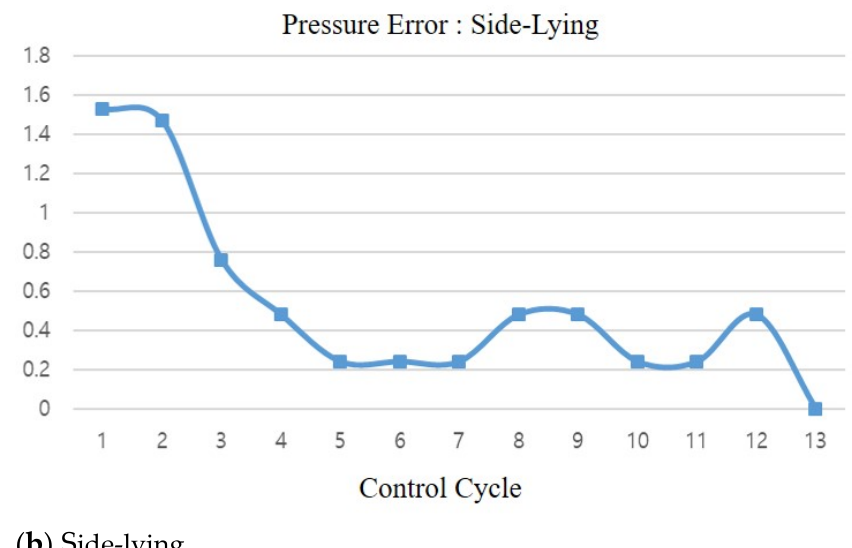
Figure 14. Fuzzy pressure control performance.